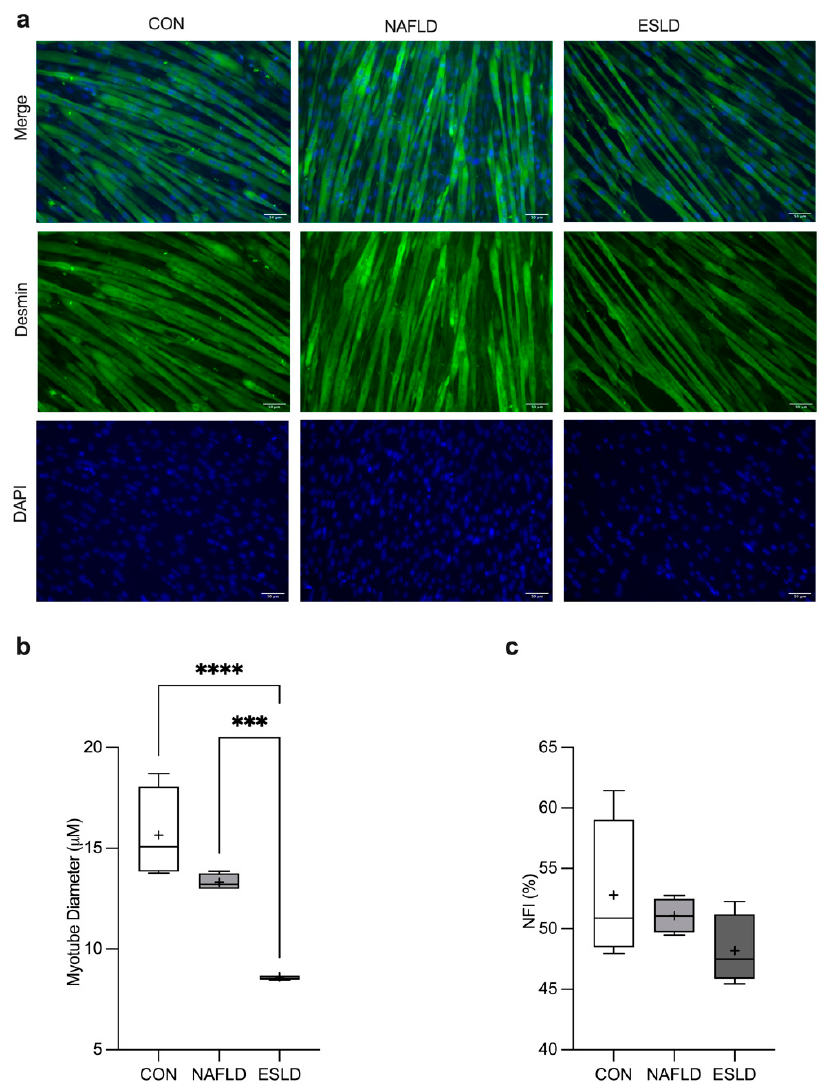
Figure 1. Serum from NAFLD and ESLD patients induces myotube atrophy. ( a ) Representative images illustrating atrophy in myotubes treated with ex vivo serum from non-alcoholic fatty liver disease (NAFLD) and end stage liver disease (ESLD) patients, in comparison to myotubes treated with serum from age-matched control participants (CON), ( b ) mean myotube diameter, ( c ) mean nuclear fusion index (NFI). Data are expressed as the mean (cross), median (central horizontal line), 25th and 75th percentiles (box) and the minimum and maximum values (vertical lines), with n = 4 per group and each data point corresponding to the average of 3 technical repeats. **** p < 0.0001, *** p < 0.001.